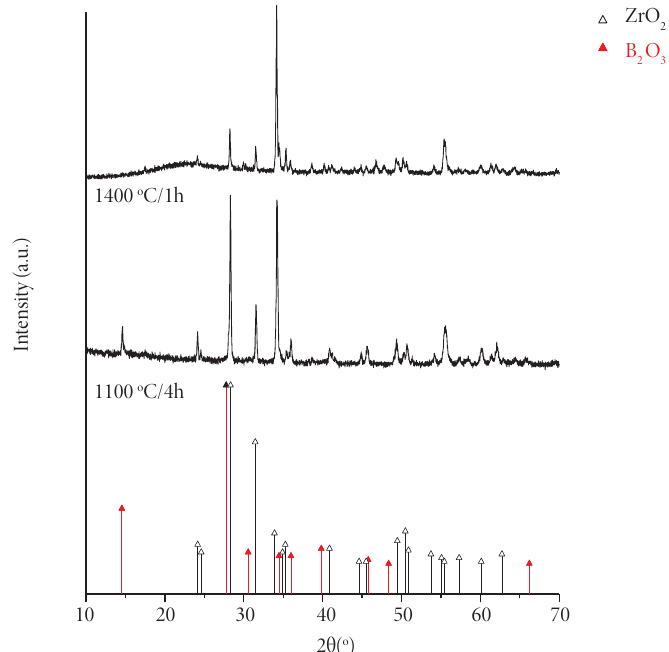
Figure 10. XRD patterns of MZ-30SiC composite oxidized at 1100°C/4h and 1400 °C/1h.